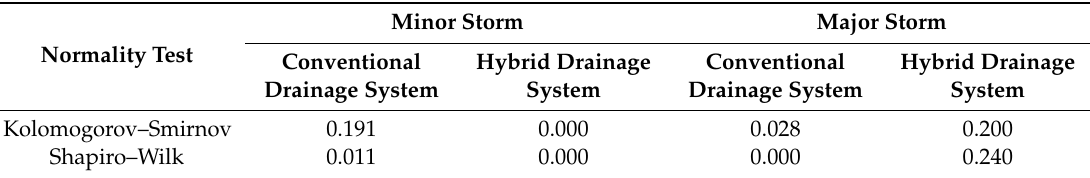
Table 2. Normality test of freeboard for the two drainage systems.